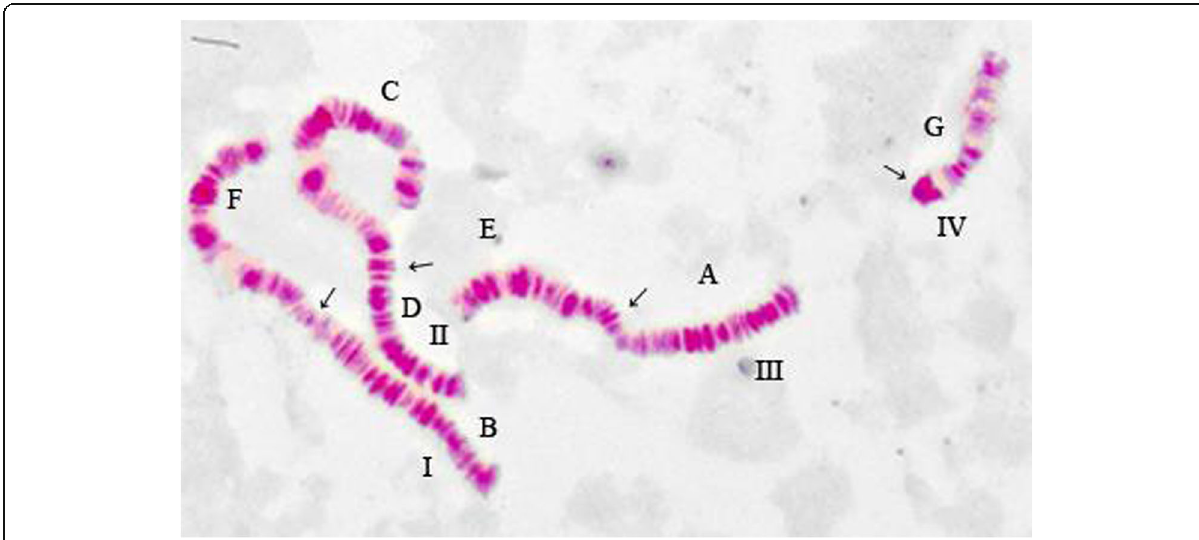
Fig. 10 Four polytene chromosomes of C. javanus (Kieffer). The chromosome I is a combination of arms B and F while the chromosome II is a combination of arms A and E. The chromosome III is a combination of arms C and D and the chromosome IV represents the arm G. Arrows represent centromeres